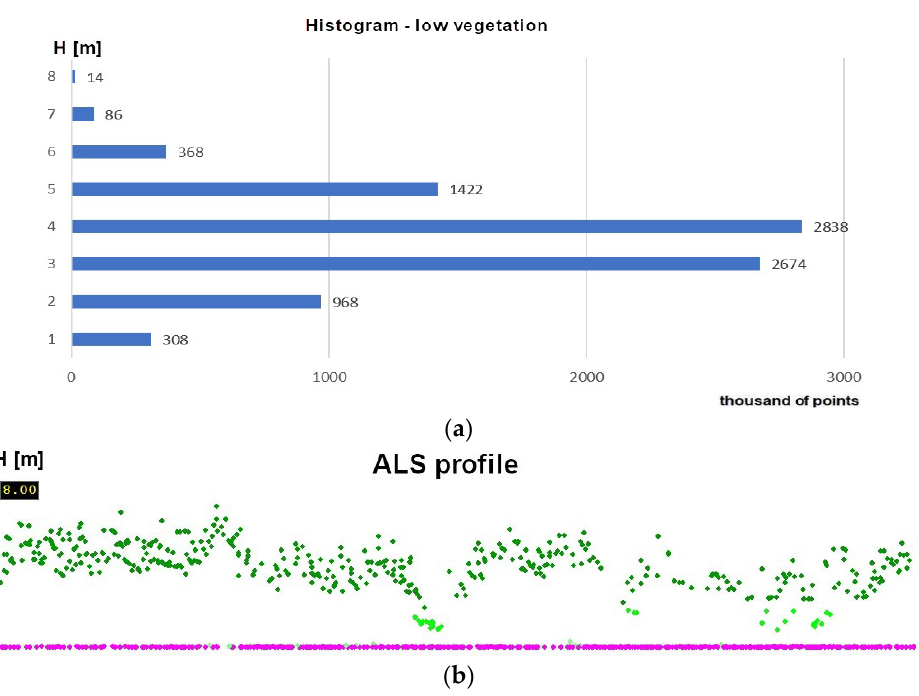
Figure 9. Low vegetation: ( a ) histogram; ( b ) profile.